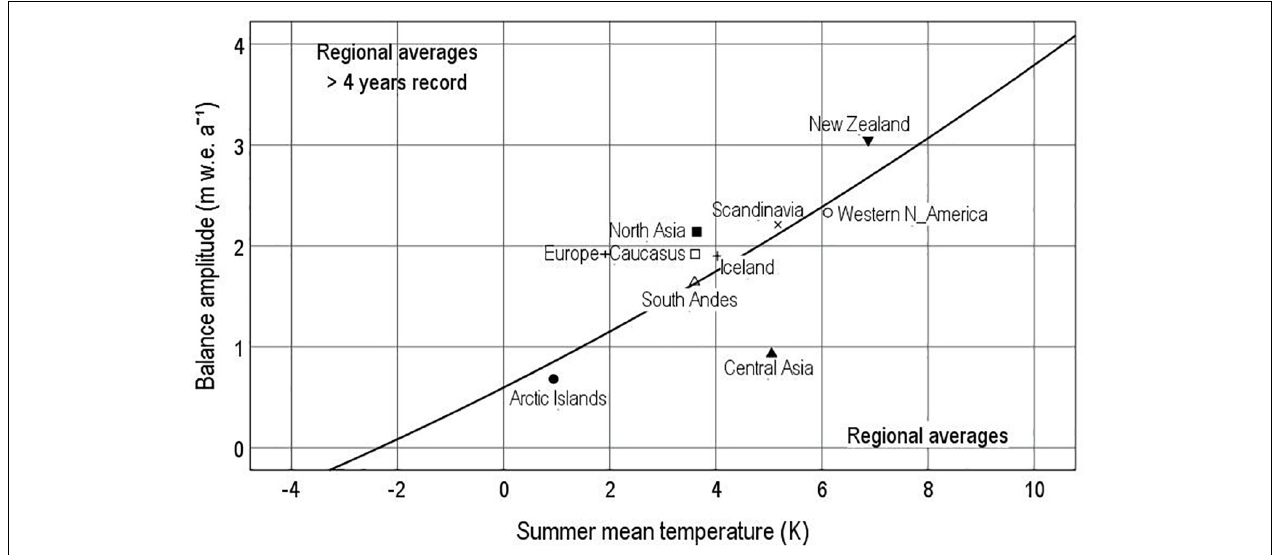
FIGURE 9 | Regional averages for balance amplitude and summer temperature in nine regions. Balance amplitude data are for glaciers with > 4 years record, and summer temperature is from Climatic Research Unit (CRU)/University of East Anglia (UEA) gridded climatology (New et al., 1999).